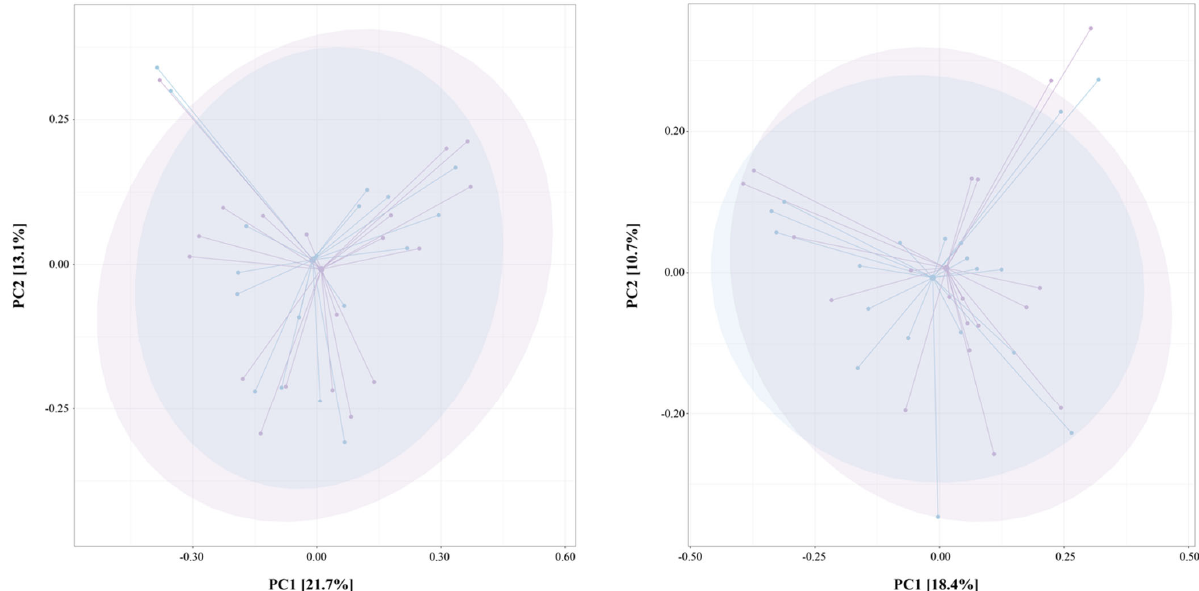
Figure 3. Principal Coordinate Analysis of Bray–Curtis distance for beta-diversity evaluation between baseline (blue samples) and low-calorie (on the left ) and two-phase (on the right ) diets (violet sample). PC1 and PC2 represent the top two principal coordinates that captured most of the